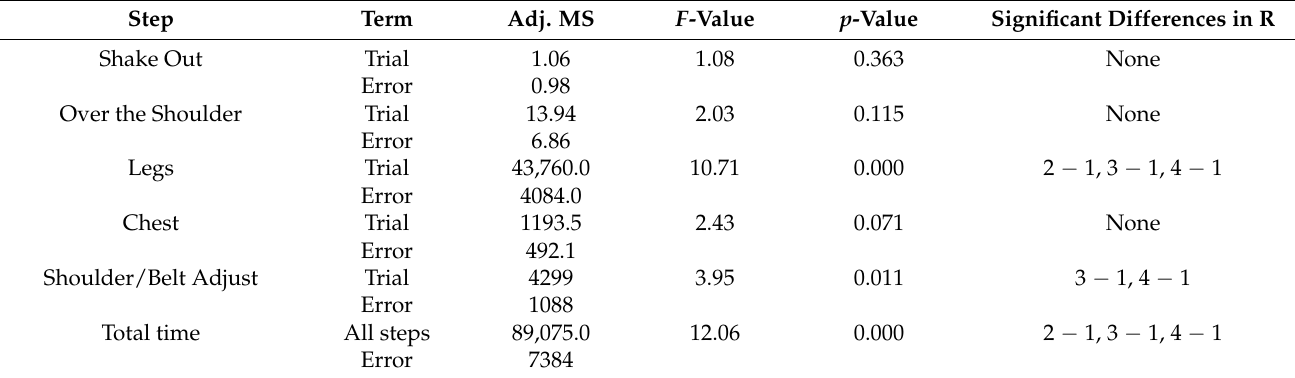
Table 5. Step-specific one-way ANOVA results for the time affected by repetition.